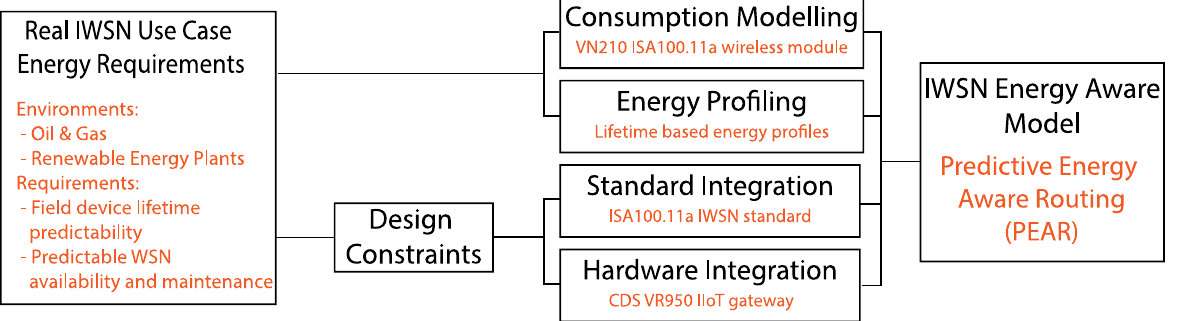
Figure 2. The PEAR implementation of the energy aware conceptual model respecting the ISA100.11a IWSN